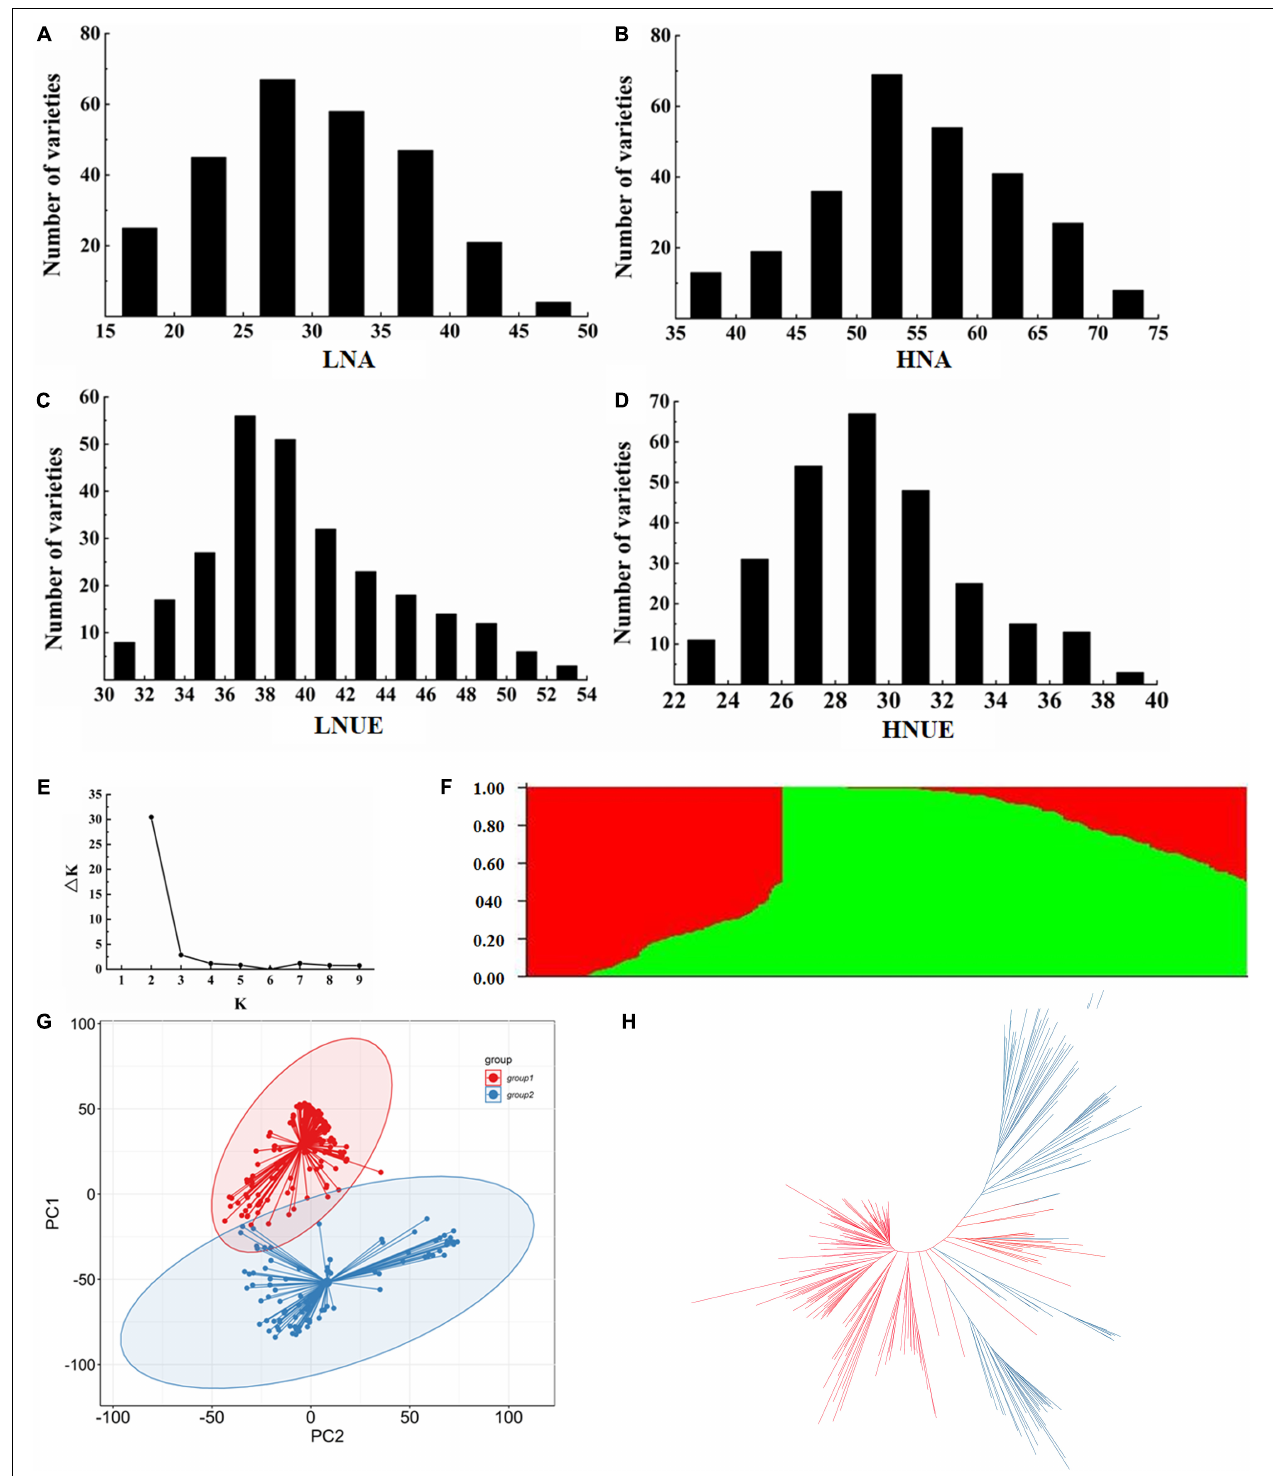
FIGURE 1 | Phenotypic variation and population structure in 267 japonica rice varieties. (A–D) represent the LNA, HNA, LNUE, and HNUE of natural populations, respectively. (E) The variation curve of (cid:49) K with K value. (F) Subgroups ( K = 2) inferred using ADMIXTURE software. (G) Principal component analysis of 267 japonica rice varieties. Colors of red and blue represent G1 and G2 in (F) , respectively. (H) Neighbor-joining tree of 267 japonica rice varieties. Colors of red and blue represent G1 and G2 in (F) , respectively.